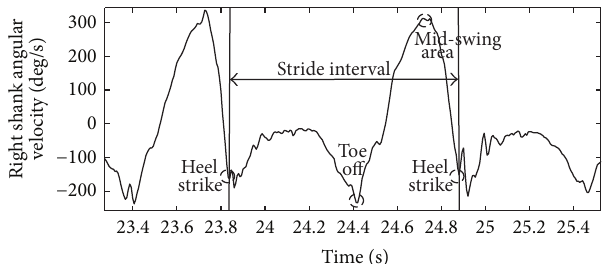
Figure 1: Schematic of shank angular velocity gait events and stride interval.